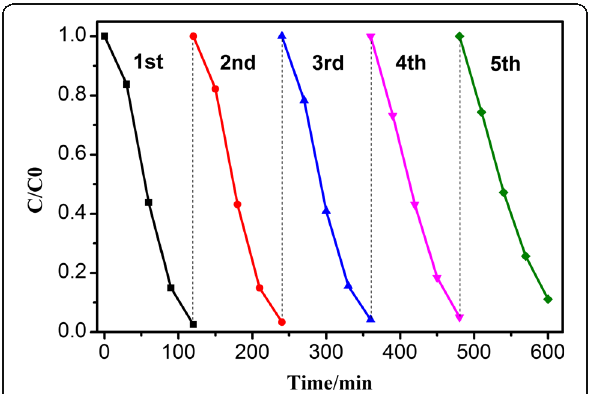
Fig. 7 Photoluminescence spectra of pristine BiVO 4 , Ag/BiVO 4 , BiV 0.9925 Mo 0.0075 O 4 , and Ag/BiV 0.9925 Mo 0.0075 O 4 composites